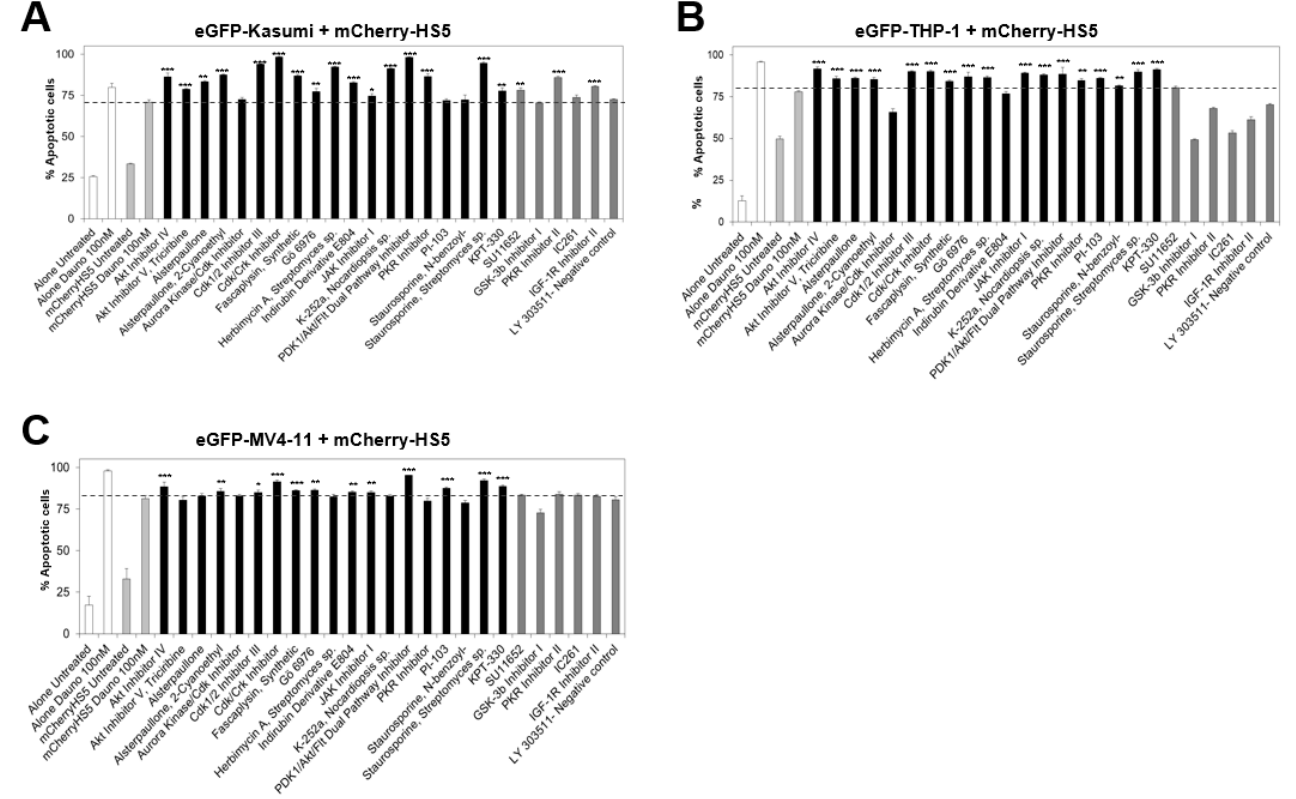
Figure 5. Analysis of the cytotoxic effects of the combination of daunorubicin with the hit compounds identified in the initial drug screening on eGFP – Kasumi, eGFP – THP-1, and eGFP – MV4-11 in co-culture with mCherry-HS5 cells. Graphs show the average percentage and SD of apoptotic eGFP – AML cells cultured alone (white bars) or in the presence of mCherry-HS5 cells (light grey bars) and were left untreated or were treated with 100 nM of daunorubicin. Co-cultures were also treated with 100 nM of daunorubicin in combination with the drugs labelled in the x axis. Black bars indicate previously identified hit compounds and dark grey bars, compounds discarded as effica- cious in the screening using eGFP – MOLM-14. Graphs show the results using eGFP – Kasumi ( A ), eGFP – THP-1 ( B ), and eGFP – MV4-11 ( C ). * p < 0.05, ** p < 0.01, *** p < 0.005 ANOVA versus eGFP- AML cells in co-culture with mCherry – HS5 treated with 100 nM of daunorubicin. We then tested the efficacy of the selected hit compounds to overcome the possible cytoprotection of AML cells mediated by osteoblasts. Osteoblasts comprise a critical haematopoietic BM niche that supports the survival of normal haematopoietic stem cells and long-term haematopoietic progenitors, as well as pre-leukaemic stem cells [14]. There- fore, the interaction of AML stem cells with osteoblasts plays a crucial role in AML tumour initiation during the onset of the disease [14] and in resistance to therapeutic drugs [21,22]. Similarly, to the results obtained with mCherry-HS5 cells, the proliferation of AML cells